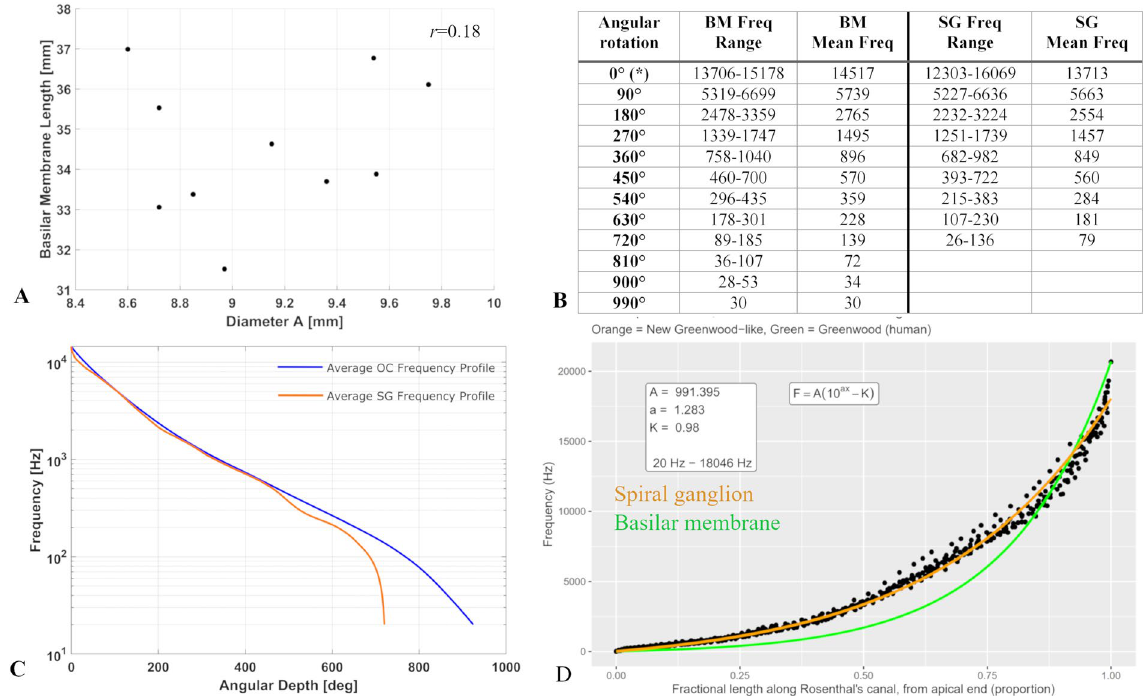
Figure 3. ( A ) Basilar membrane length is plotted against diameter A . No correlation was noted between these values ( r = 0.18). ( B ) Table showing mean angular frequencies obtained from ten specimens imaged using synchrotron radiation phase-contrast imaging. ( C ) Average basilar membrane and spiral ganglion frequencies plotted against cochlear angular depth. This average curve was determined by calculating the mean angular depth of each frequency in all samples. ( D ) Results of least squares fitting an exponential function to 3D SR-PCI SG tonotopic data. Greenwood’s function for the BM tonotopic distribution is illustrated in green for reference, and the SG function relating proportional length to tonotopic frequency developed herein is illustrated in